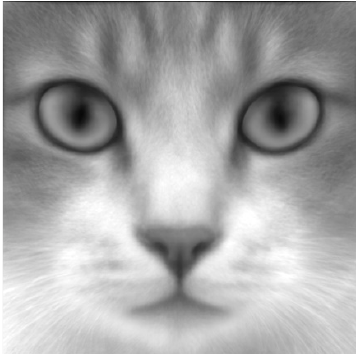
Figure 3. An image of the average face of owned domestic mixed breed created by morphing.